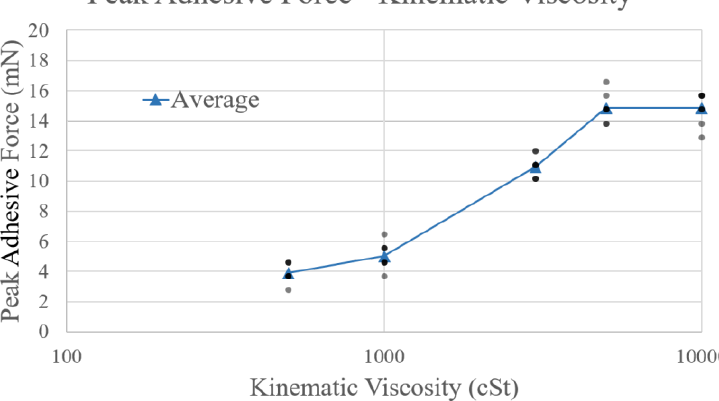
Figure 16. Plot of peak values of adhesive force (mN) and kinematic viscosity (cSt). The blue line indicates the average peak value, whereas the gray points indicate the row data (for standard viscosity liquids of 500, 1000, 3000, 5000, and 10,000 cSt).